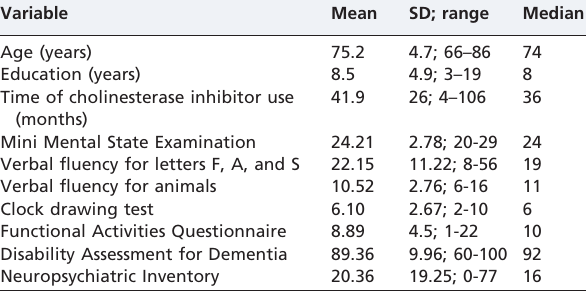
Table 1 - Description of demographic, clinical, cognitive, functional, and behavioral data.